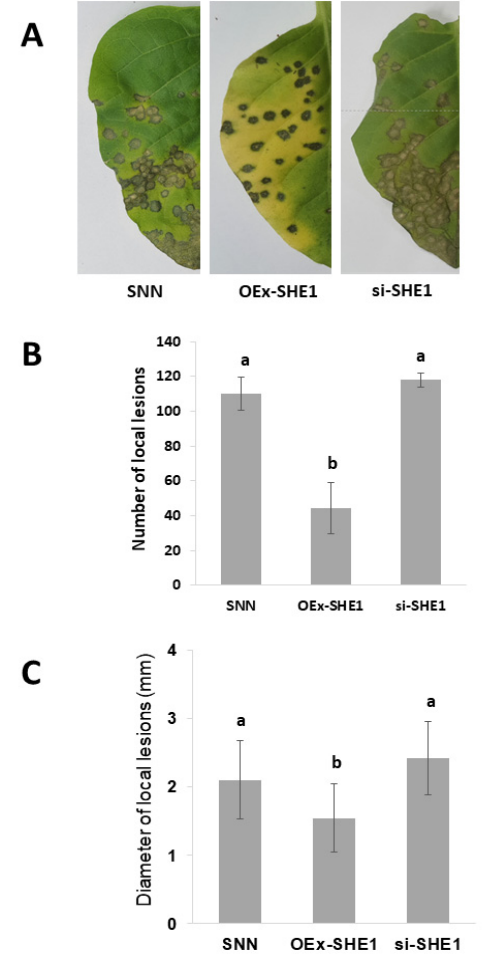
Figure 2. Effect of silencing or over-expressing SHE1 on local movement of TMV in infected tobacco cv. Samsun NN. ( A ) Local lesion induced on half-leaves of tobacco plants inoculated with TMV, nontransformed (SNN) or either transformed to overexpress (OEx-SHE1) or silence (si-SHE1) the SHE1 gene. (B, C) Histograms showing the mean and standard deviation (error bars) of either ( B ) the number of local lesions or ( C ) the estimated diameter of local lesions induced by TMV infection on SNN, SNN-OEx-SHE1 or SNN-si-SHE1. The data were analyzed statistically by Duncan’s multiple range test (DMRT). Different letters above the error bars indicate a significant difference at p < 0.01.